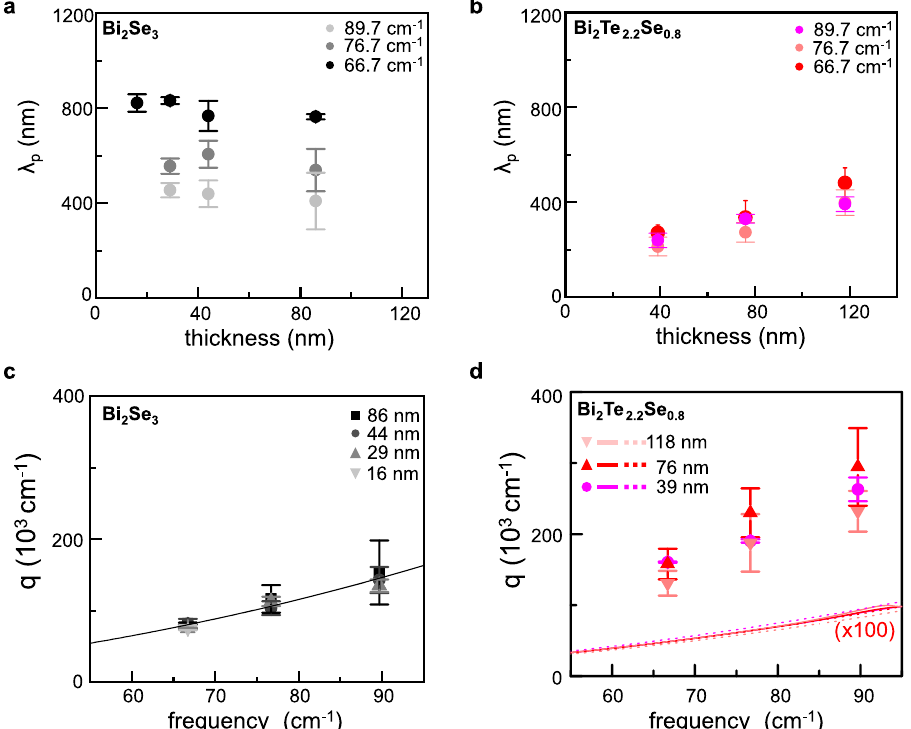
Fig. 5 Energy dispersions of propagating modes. a Plasmon wavelength λ p in Bi 2 Se 3 as a function of thickness, extracted from the interference pattern measured at 66.7 cm − 1 (black dots), at 76.7 cm − 1 (gray dots), and at 89.7 cm − 1 (light gray dots). b Wavelength λ p of the photoexcited modes in Bi 2 Te 2.2 Se 0.8 as a function of fl ake thickness extracted from the interference pattern measured at 66.7 cm − 1 (red dots), at 76.7 cm − 1 (light red dots), and 89.7 cm − 1 (magenta dots). c Plasmon energy dispersion in Bi 2 Se 3 for different fl ake thicknesses d ranging from 86 to 16 nm (colored dots) together with the predicted dispersion law (solid line). d Energy dispersion of the photoexcited modes in Bi 2 Te 2.2 Se 0.8 for different fl ake thicknesses d ranging from 118 to 39 nm (colored dots), compared to the energy dispersion simulated for Dirac plasmons (colored solid lines) and massive bulk plasmons (colored dot lines) reported in Supplementary Fig. 12 and therein-discussed in detail. Error bars indicate the 95% con fi dence bands from the fi t of interference patterns.